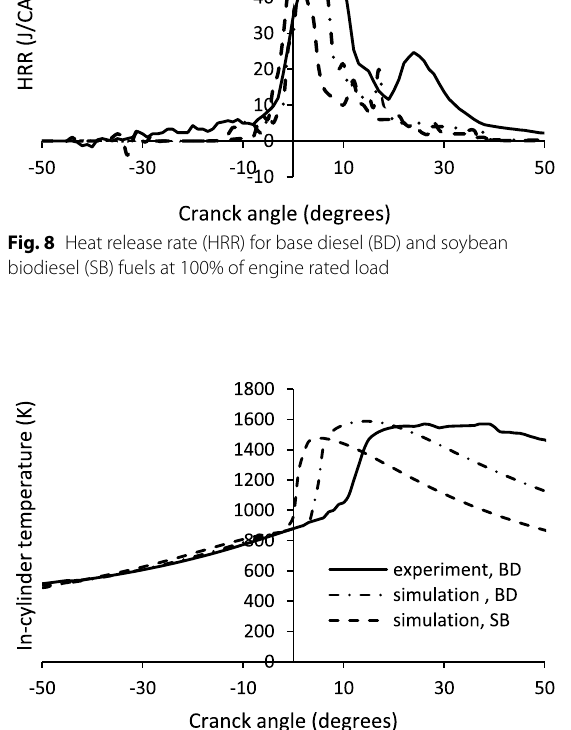
Fig. 9 In‑cylinder temperature for base diesel (BD) and soybean biodiesel (SB) fuels at 100% of engine rated